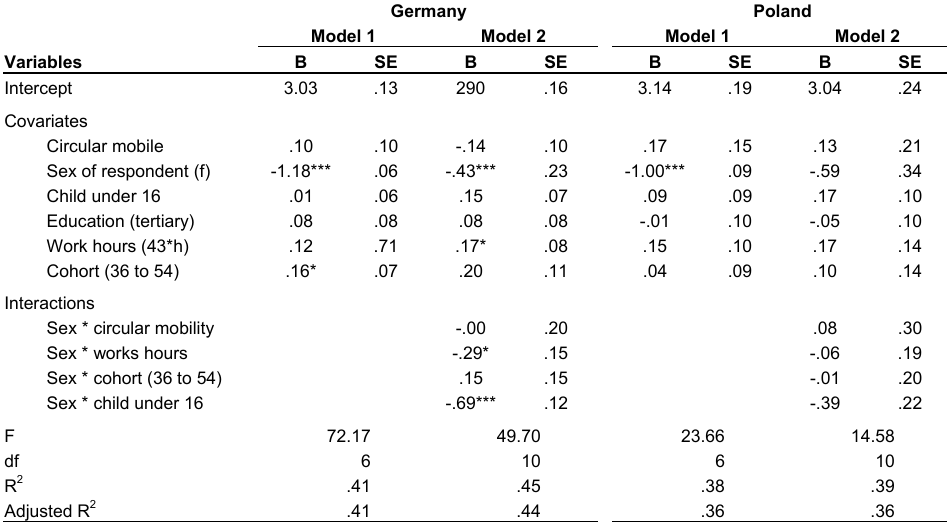
*p ≤ .05; **p ≤ .01; ***p ≤ .001 Data: Job Mobility and Family Lives Survey 2007, employed men and women living in